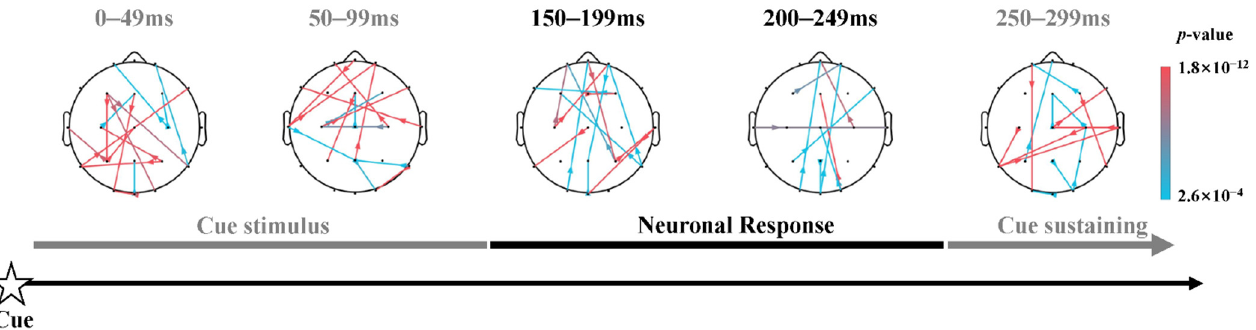
Figure 7. Dynamic information flow corresponding to the alerting network within 3 distinct sub- stages after the onset of cue. Stronger information flow induced by center cue condition compared to no cue condition ( t (38) = 4.826, p < 0.001, FDR corrected).